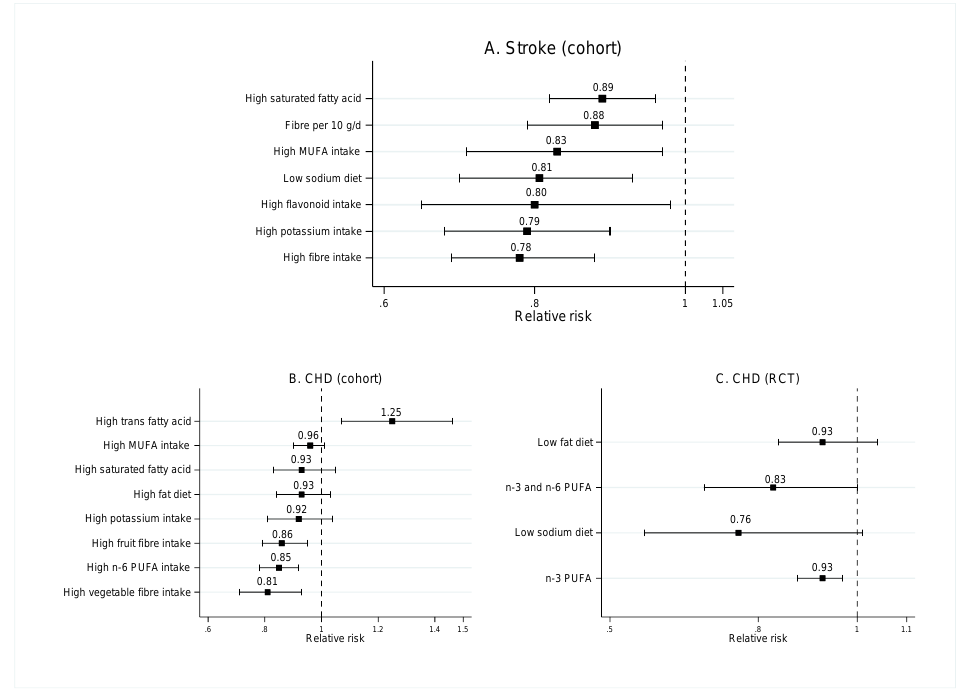
Figure 5. Pooled risk ratios for food nutrients and the risk of stroke and coronary heart disease. Results are from systematic reviews and meta-analyses of observational studies for A and B , and systematic reviews and meta-analyses of RCTs for C .